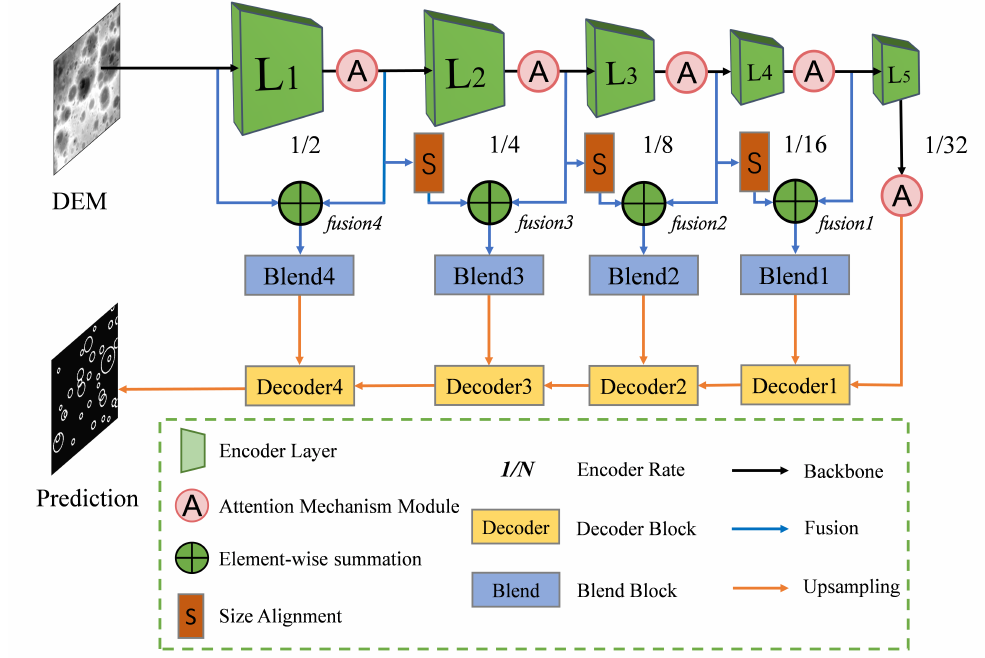
Figure 2. AFNet framework based on the improved VGG-16. The input is the DEM image transferred to the network encoder process (green trapezoid). First, the DEM image is processed with a 1/ N downsampling rate with an attention mechanism module (pink circle) and five convolution blocks. Then, feature maps with different resolutions are saved and fused by the multiscale feature fusion module (blue line) with element-wise summation (green (cid:76) ) and the data blending block (blue squares) through the decoder process (yellow squares) to get a more fine-grained output feature map. The final output result denotes the network prediction results with pixel-level